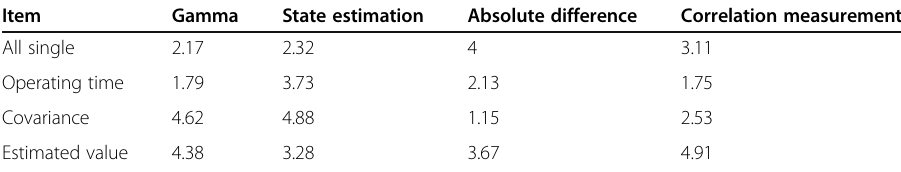
Table 3 The cross-correlation matrix and the posterior probability Item Gamma State estimation Absolute difference Correlation measurement All